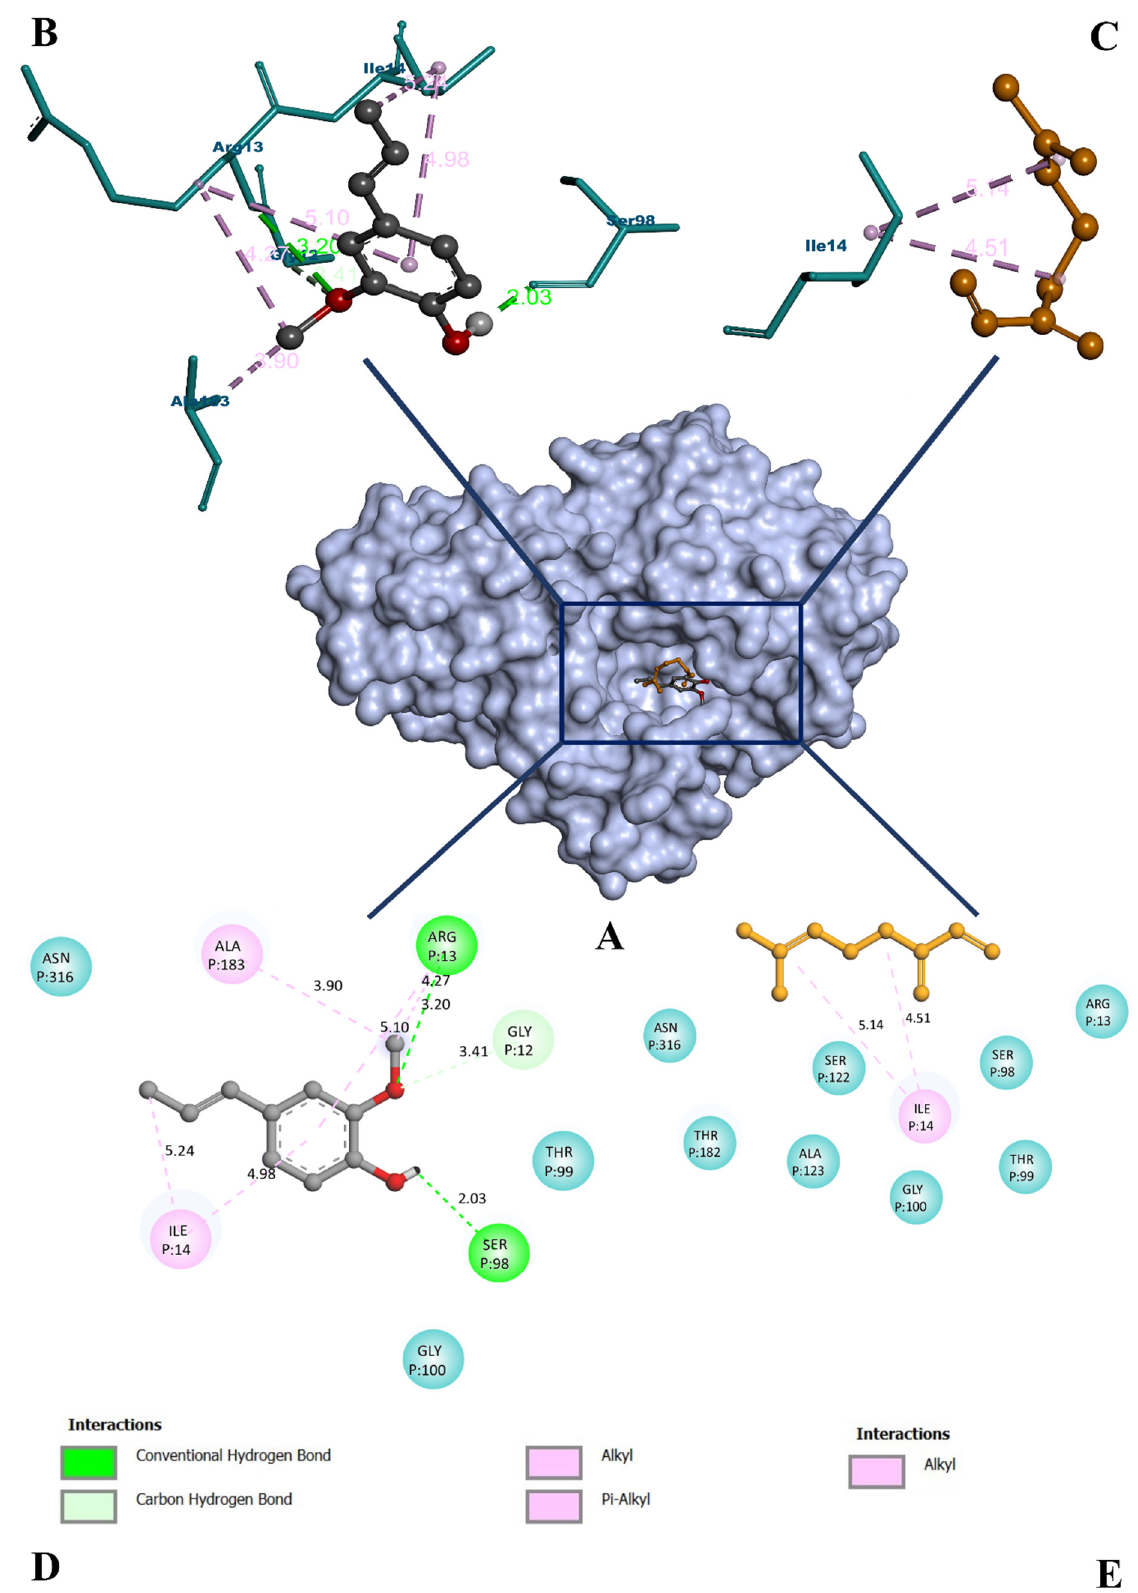
Figure 7. ( A ) The surface interaction view of GAPDH protein bound with isoeugenol (grey) and myrcene (orange). ( B , C ) The 3D representation of isoeugenol and myrcene binding to the residues, respectively. ( D , E ) The 2D representation of isoeugenol and myrcene binding to the residues, respectively. Teal: surrounding non ‐ binding residues, colored: bound residues.